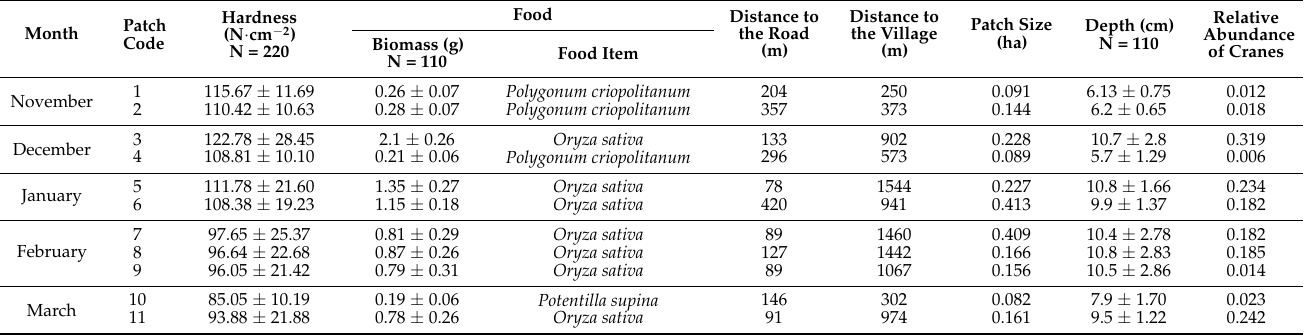
Table A4. Characteristics of the surveyed patches at Caizi Lakes (The food item was the main food resources for